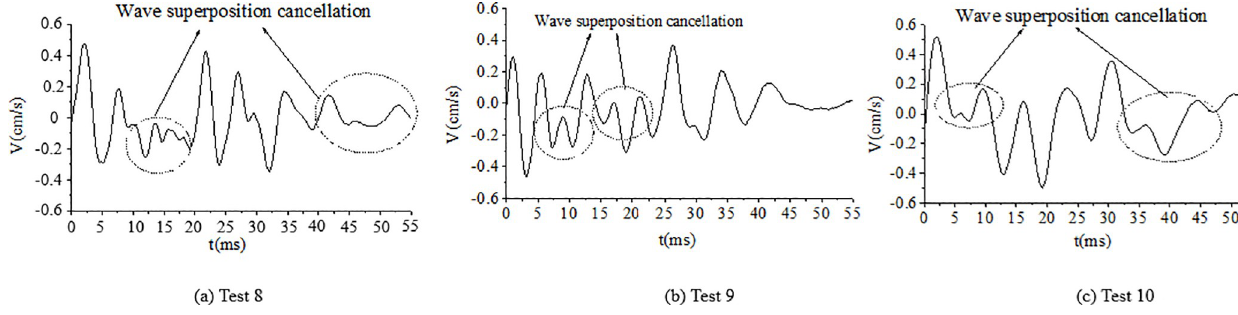
Fig 17. Vibration velocity curves of blasting signals for cut holes for a delay time of 5 ms.